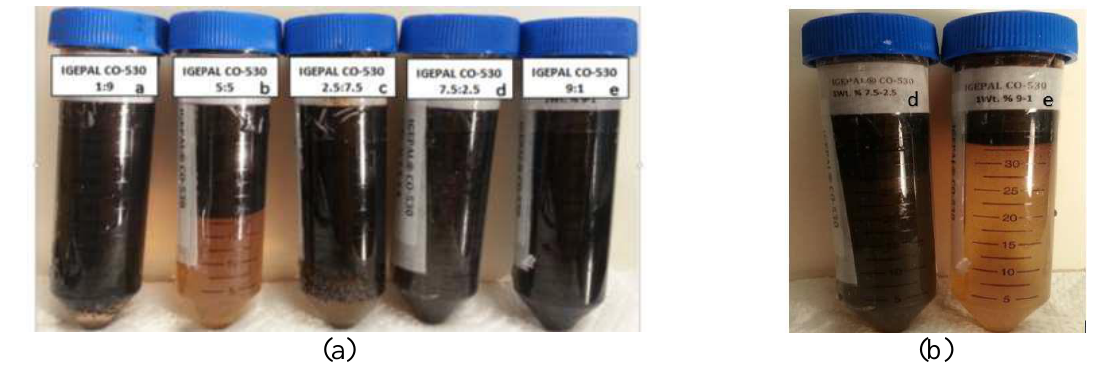
Figure 1—(a) 1% nonionic surfactant in 1% NaCl, from left to right, low water to high water. All at 25℃. (b) The two at high water contents at 40℃. One apparently remains stable and the other fully